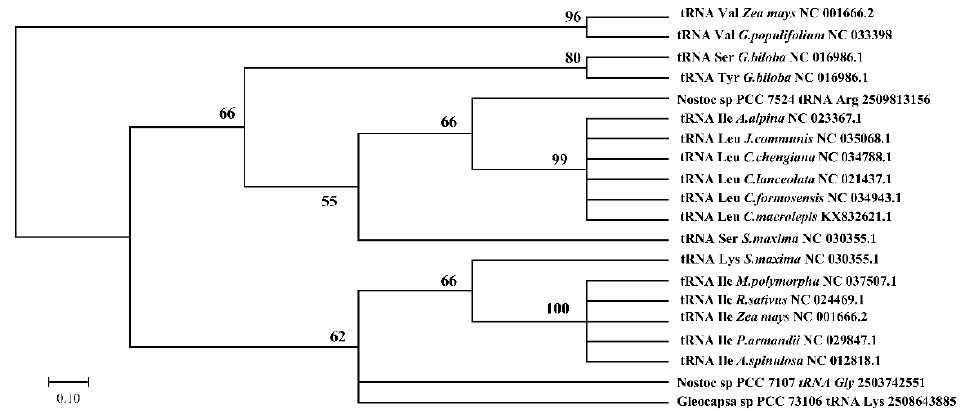
Figure 3. Phylogenetic relationship of introns in chloroplast tRNAs (from angiosperms, gymnosperms, ferns, bryophytes, and algae). Introns of chloroplast tRNA grouped with that of cyanobacteria illustrated a common cyanobacterial origin of introns in chloroplasts. Introns in chloroplast tRNA Val of Gossypium populifolium and Zea mays indicated the same evolutionary ancestors of corn and cotton introns. Introns present in the same tRNA of plants (tRNA Ile and tRNA Leu ) tended to appear in the same branch, showing their close phylogenetic relationship.